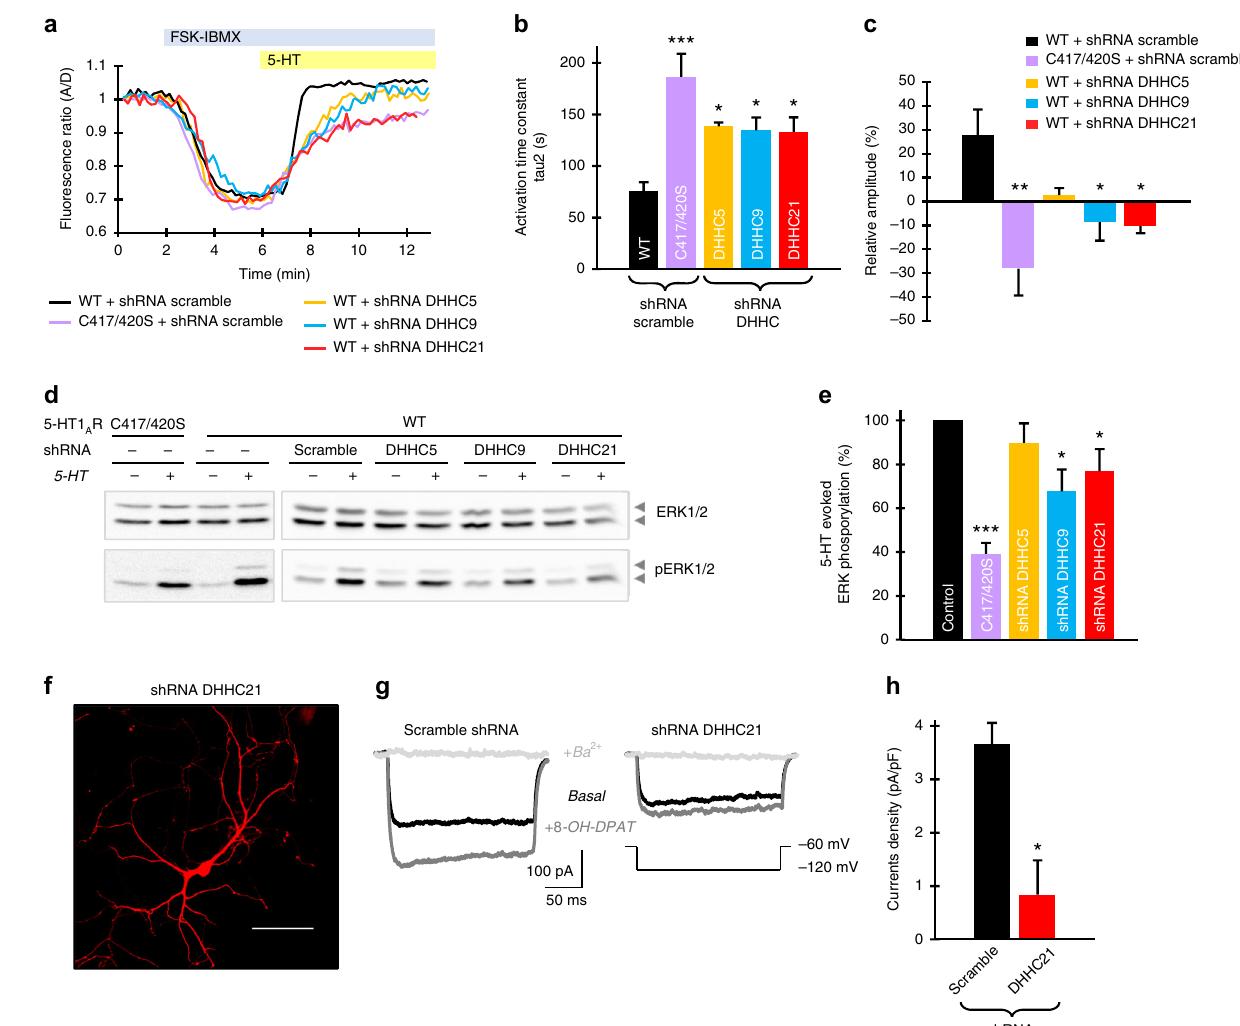
Fig. 2 Knockdown of ZDHHC5, -9, and -21 impairs 5-HT1AR-mediated signaling. a N1E cells were transfected with cAMP fl uorescence resonance energy transfer-based biosensor CEPAC and 5-HT1AR-mCherry along with the indicated constructs (see also Supplementary Fig. 4A – C). After pretreatment with 1 µ M forskolin and 25 µ M 3-isobutyl-1-methylxanthine, cells were stimulated with 20 µ M serotonin (5-HT). Each trace shows cAMP response at the single cell. b Graphs show activation time constant and c changes of cAMP response amplitude relative to pretreatment ( N = 4, in each experiments at least 20 cells were analyzed; one-way analysis of variance (ANOVA)). d Analysis of extracellular signal – regulated kinase (Erk) phosphorylation in N1E cells expressing the indicated constructs after stimulation with 10 µ M 5-HT. e Quanti fi cation of 5-HT evoked Erk phosphorylation calculated as the ratio of total Erk expression over the Erk phosphorylation signal. Bars show means± SEM ( N ≥ 7, one-way ANOVA; see also Supplementary Fig. 4D, E). f Representative image of hippocampal neuron expressing short hairpin RNA against ZDHHC21 together with red fl uorescent protein at the day in vitro 11. Scale bar: 100 μ m. g Examples of G-protein gated inwardly rectifying potassium (GIRK) channel currents in two transfected groups after application of 5-HT1AR agonist 8-OH-DPAT and channel blocker BaCl 2 . h A summary of recordings from three independent culture preparations. Bars show means± SEM of the amplitude of 8-OH-DPAT-stimulated GIRK currents. * P < 0.05; ** P < 0.01; *** P < 0.001, two-tailed t test. Source data are available as a Source Data fi